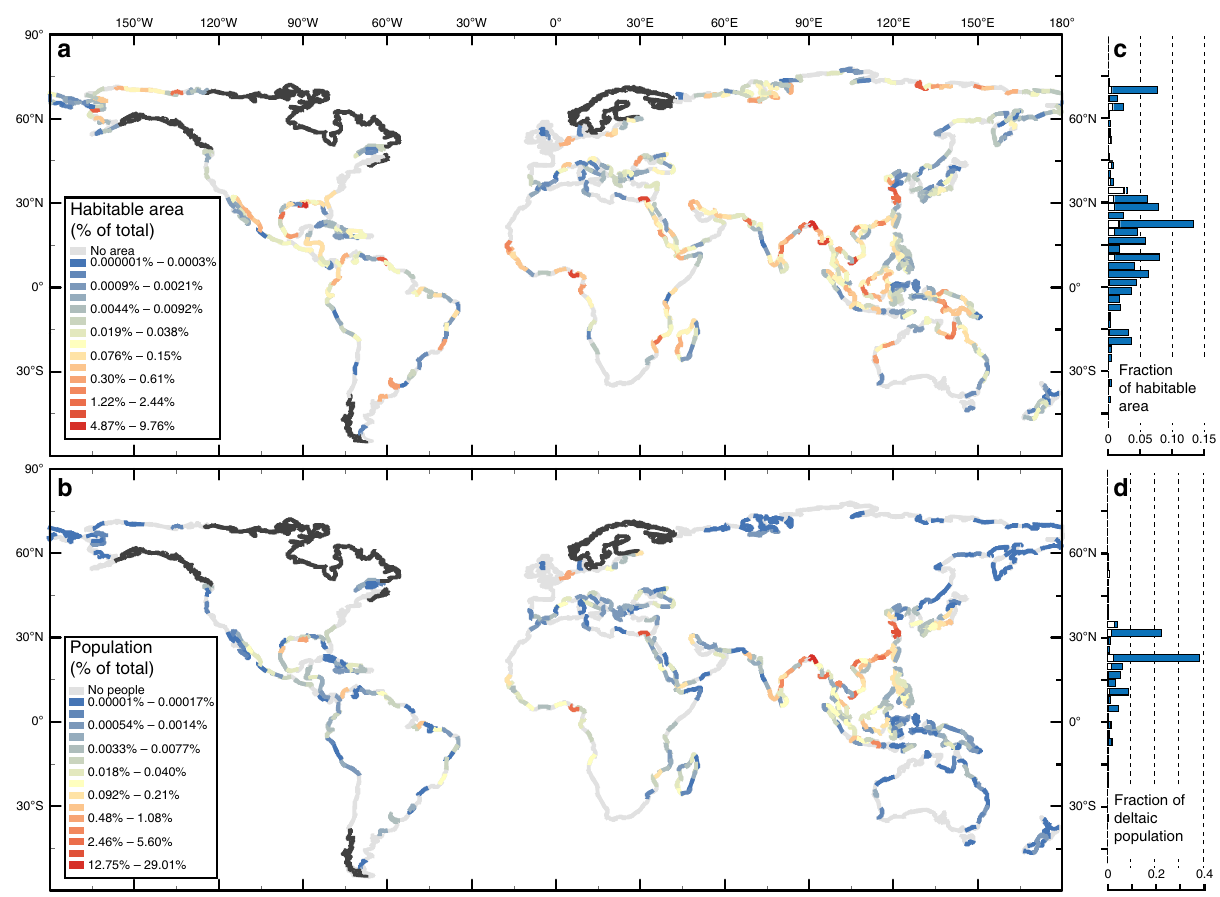
Fig. 1 Global distribution of deltaic area and population. a , b Total deltaic area and population per 3° lengths of coastline. Lengths of coastlines are colored by the percentage of area or population they contain relative to the entire dataset. Black lines are unmapped shorelines from Caldwell et al. 27 . c , d Histograms showing the latitudinal distribution (3° bins) of habitable area and population. White bars show the proportion of area and people in the 100-year storm surge fl oodplain.